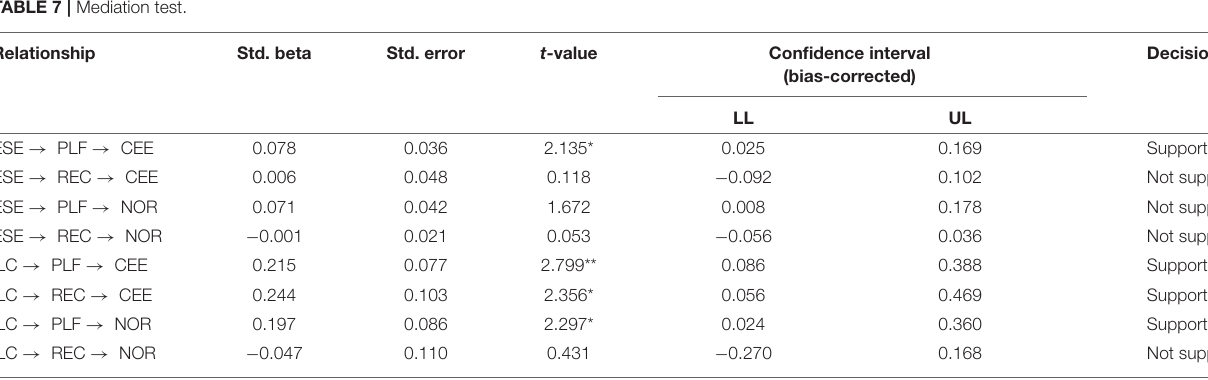
TABLE 7 | Mediation test. Relationship Std.